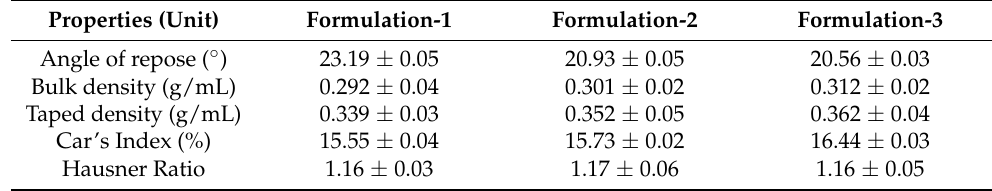
Table 4. Results of pre-compression evaluation of controlled-release tablets of clarithromycin.